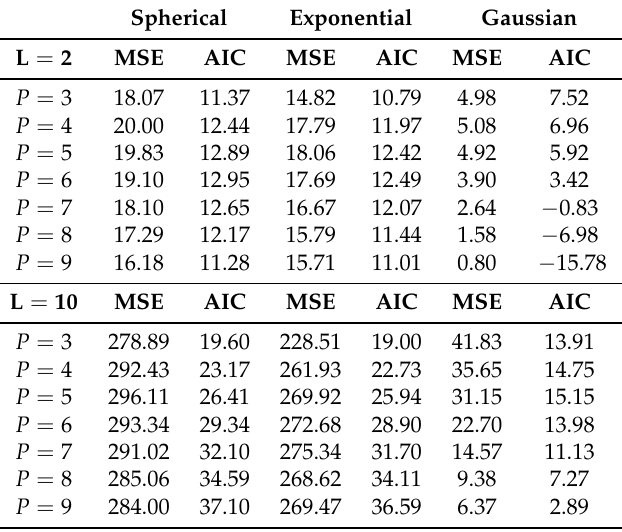
Table 2. Semivariogram modeling (MSE and AIC) in the asymmetric case for L = 2 and L = 10. Minimums are highlighted in violet